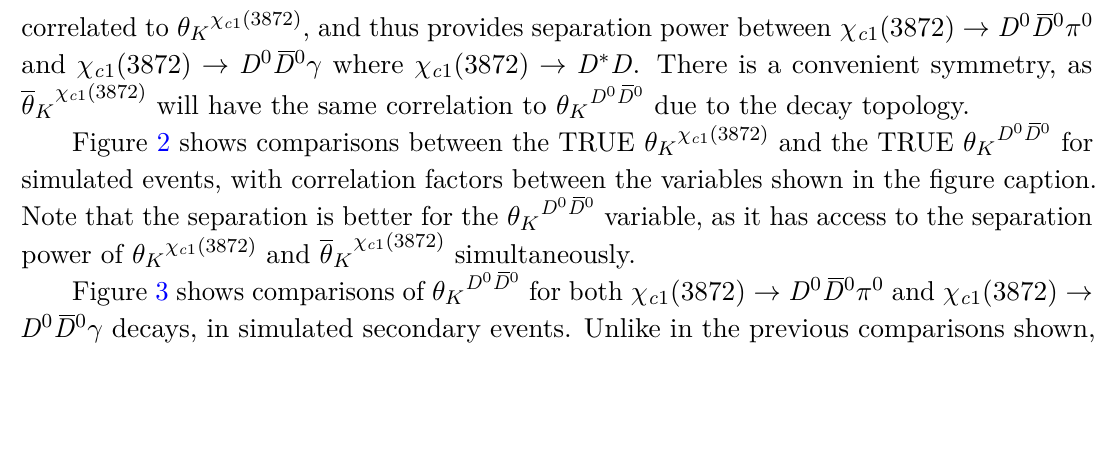
Figure 1. − m 2 compared for prompt (a) χ c 1 (3872) → D 0 D 0 π 0 50/50 (light blue) vs. ( D 0 − D 0 ) χ c 1 (3872) → D 0 D 0 γ 50/50 (grey, dashed line), (b) χ c 1 (3872) → D 0 D 0 π 0 Model (light blue) vs. χ c 1 (3872) → D 0 D 0 γ 50/50 (grey, dashed line), (c) D 0 D 0 Flat Background Sample (light blue) vs. χ c 1 (3872) → D 0 D 0 π 0 50/50 (grey, dashed line), (d) D 0 D 0 Flat Background Sample (light blue) vs. χ c 1 (3872) → D 0 D 0 γ 50/50 (grey, dashed line), (e) χ c 1 (3872) → D 0 D 0 π 0 50/50 S-Wave only (light blue) vs. χ c 1 (3872) → D 0 D 0 γ 50/50 S-Wave only (grey, dashed line), and (f) χ c 1 (3872) → D 0 D 0 π 0 PHSP (light blue) vs χ c 1 (3872) → D 0 D 0 γ PHSP (grey, dashed line). Where the sample sizes are equal, the fraction of χ c 1 (3872) → D 0 D 0 π 0 (or equivalently χ c 1 (3872) → D 0 D 0 γ ) events in the overlap region is displayed on each